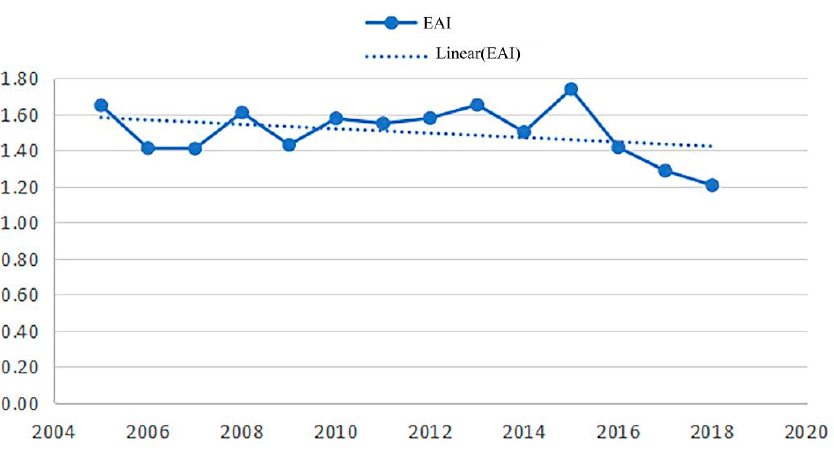
Figure 2. Xinjiang cotton production efficiency advantage (EAI).